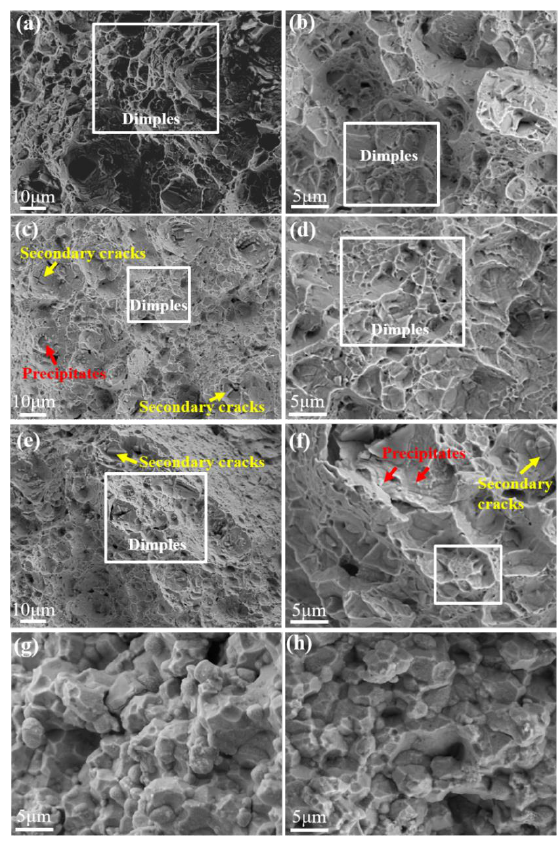
Figure 8. SEM images showing the fracture surface morphologies after tensile tests at different temperatures: ( a , b ) RT; ( c , d ) 650 °C; ( e , f ) 760 °C; ( g ) 850 °C; ( h ) 900 °C. The yellow and red arrows, respectively, indicate the secondary cracks and the precipitates. The white square indicates dim- ples.